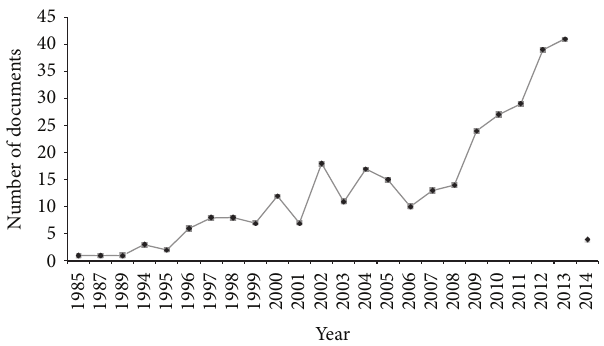
Figure 1: Number of articles published over the last 29 years.